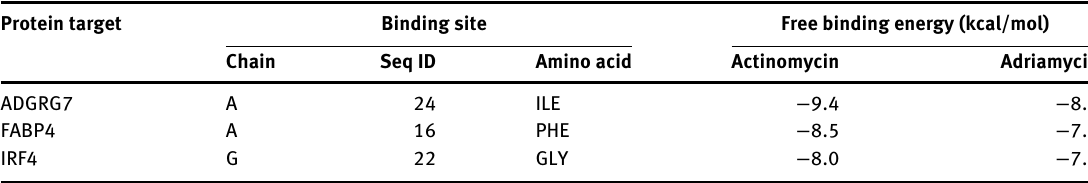
Table 1: Binding site information and docking analysis of drugs with the protein targets. Protein